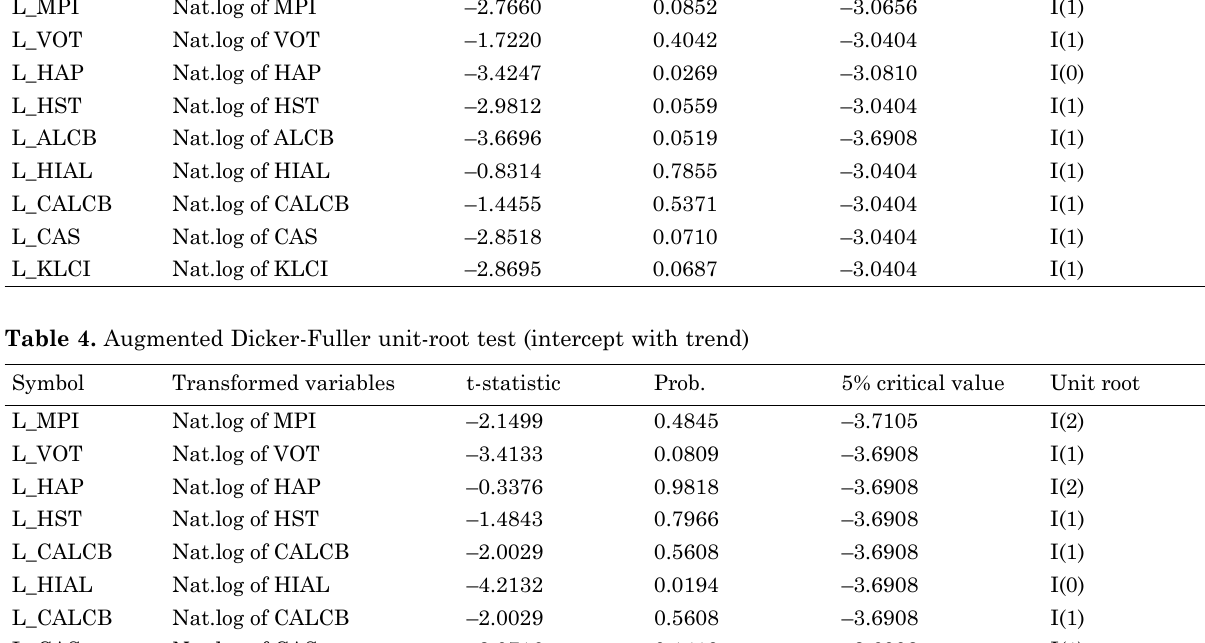
Table 3. Augmented Dicker-Fuller unit-root test (intercept without trend) Symbol Transformed variables t-statistic